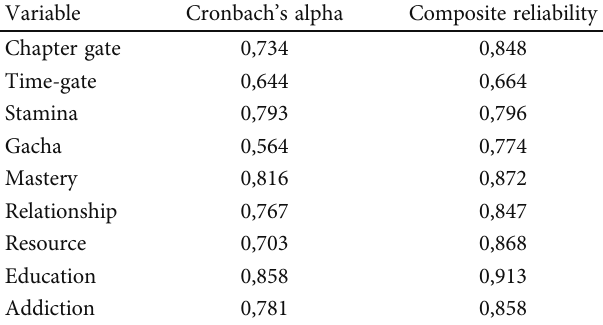
Table 4: Reliability test.